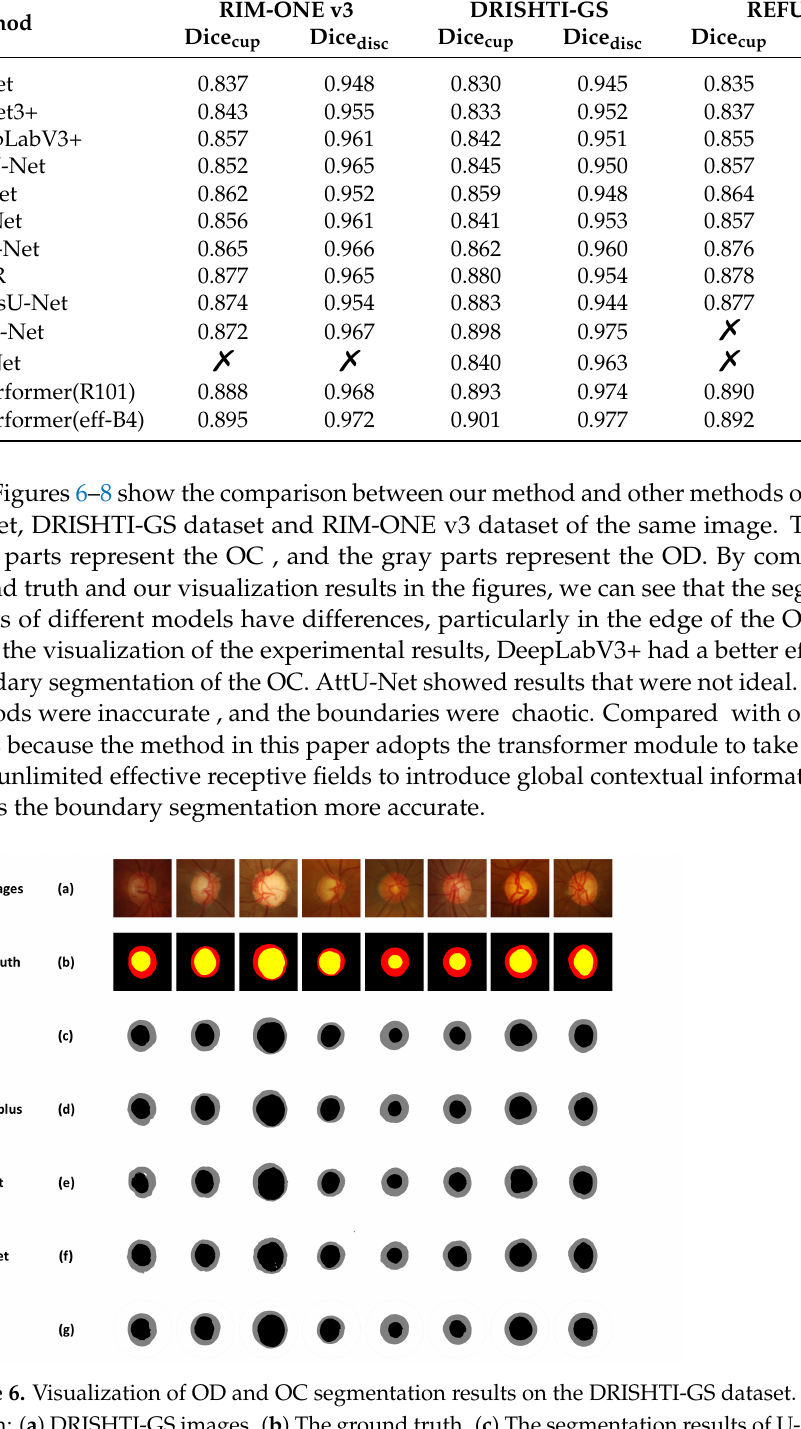
Table 1. Comparisons of our approach compared with different state-of-the-art methods on the DRISHTI-GS dataset, RIM-ONE v3 dataset and REFUGE dataset. RIM-ONE v3 DRISHTI-GS REFUGE Method Dice cup Dice disc Dice cup Dice disc Dice cup Dice disc